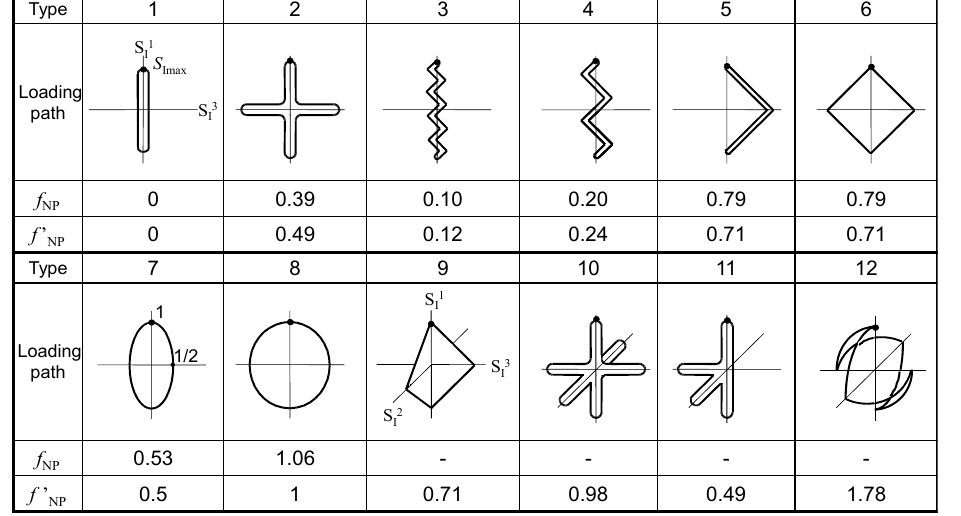
Figure 6: Comparing f NP and f ’ NP under several